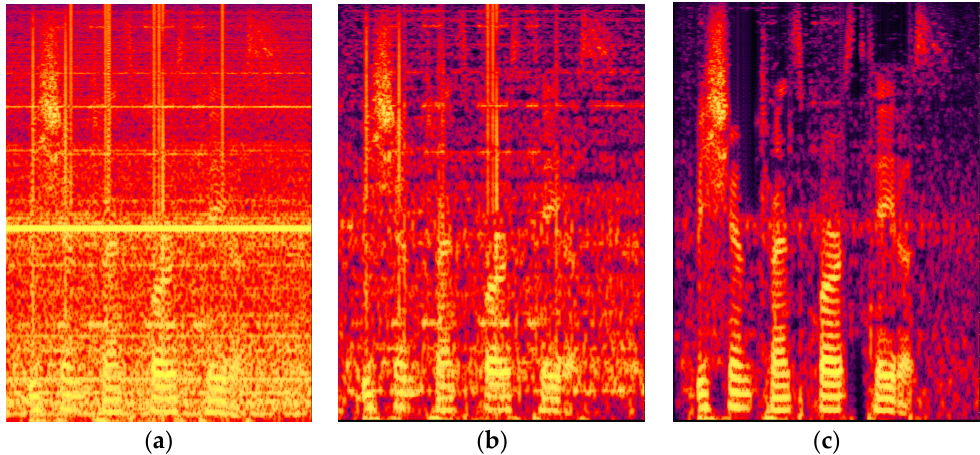
Figure 9. Comparison of spectral figures according to noise reduction approaches: ( a ) original noisy speech; ( b ) de-noised speech by spectral subtraction; ( c ) de-noised speech by proposed approach.